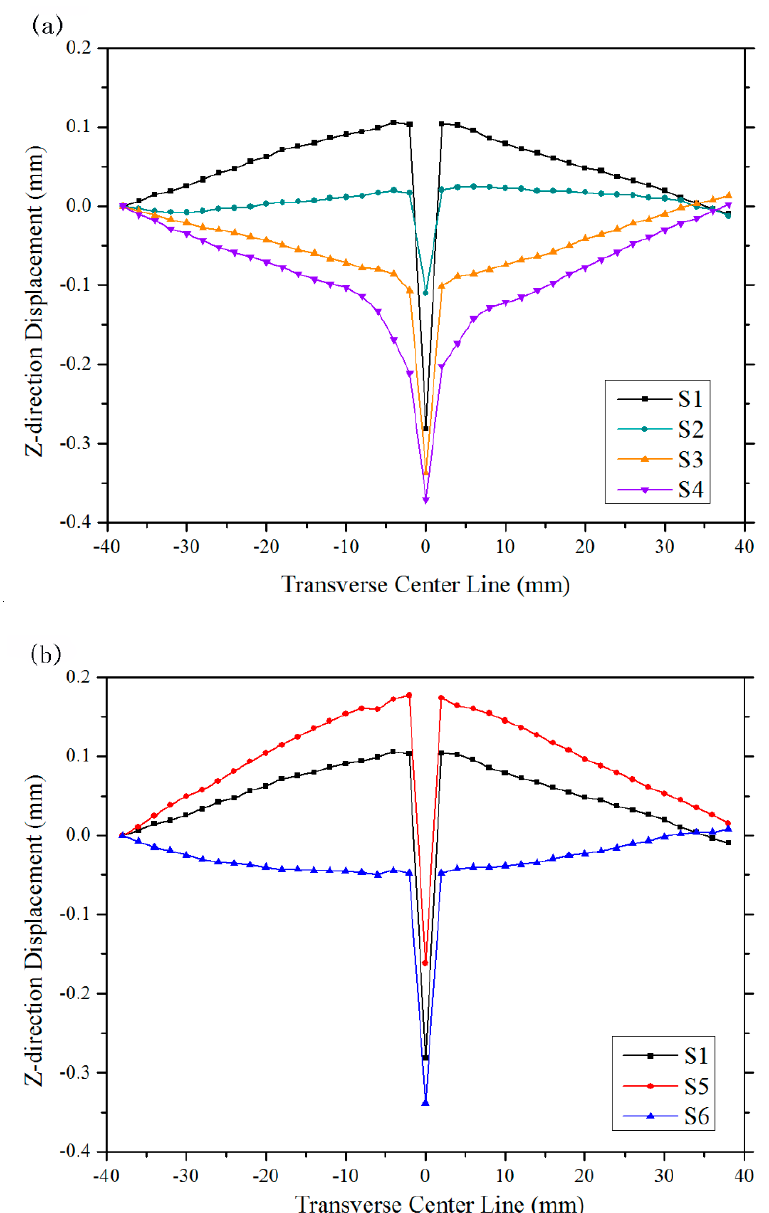
Figure 4. The Z-direction displacements of transverse center line of cases S1-S6. ( a ) Z-direction displacements of various laser powers. ( b ) Z-direction displacements of various focus offsets.